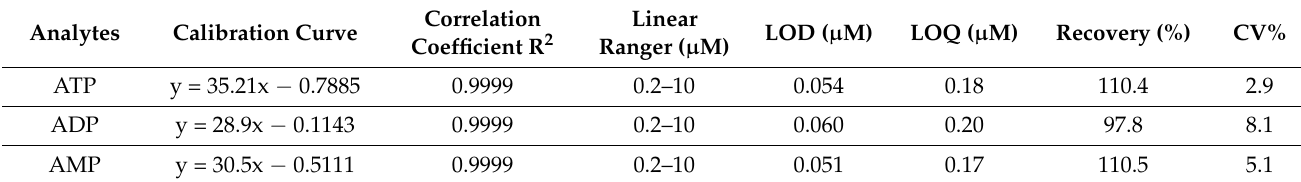
Table 1. Linear regression, LOD, LOQ, and recovery for ATP, ADP, and AMP.